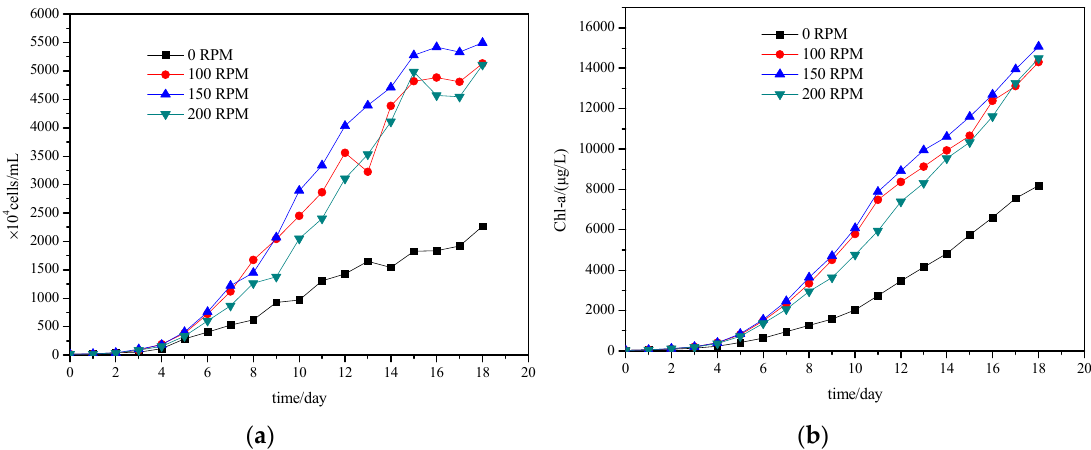
Figure 5. ( a ) Cell number density and( b ) Chl-a concentration changes in Microcystis aeruginosa under different turbulence conditions.